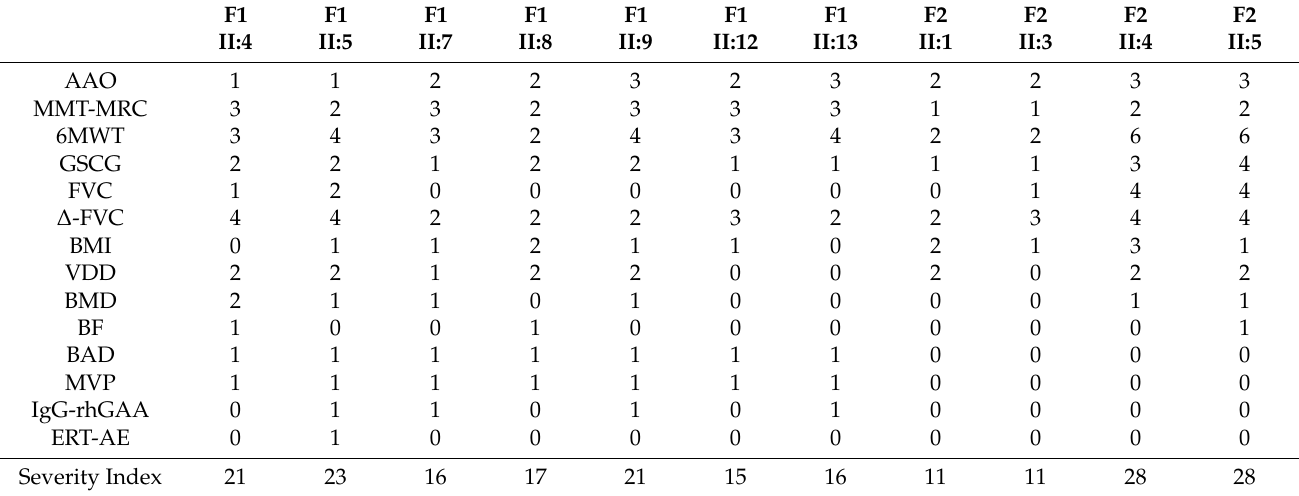
the two subgroups. The association between 6MWT, GSGC, FVC, ∆ FVC and the severity index score was also confirmed by Pearson correlation. Table 2. The severity index obtained adding the score of each clinical feature of a single LOPD patient.